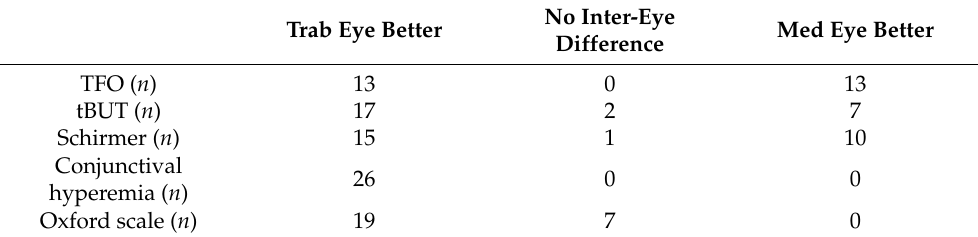
Table 3. Distribution of patients showing better parameters in the differently treated eyes.